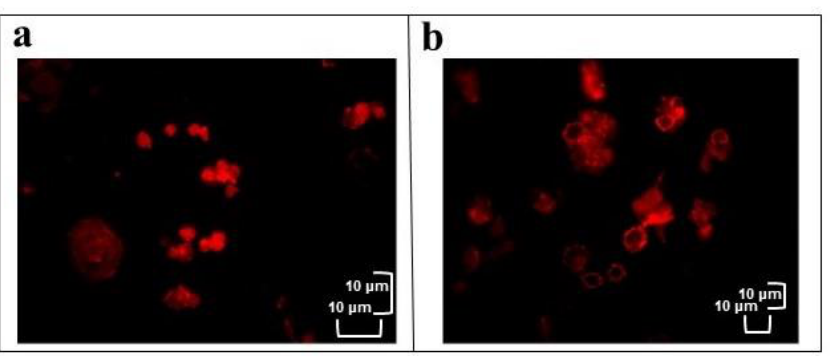
Figure 6. In vitro healthy haemocytes ( a ) or treated with OPs for 2 h ( b ) and stained with TRITC- Conjugated phalloidin. Scale bar 10 μm.